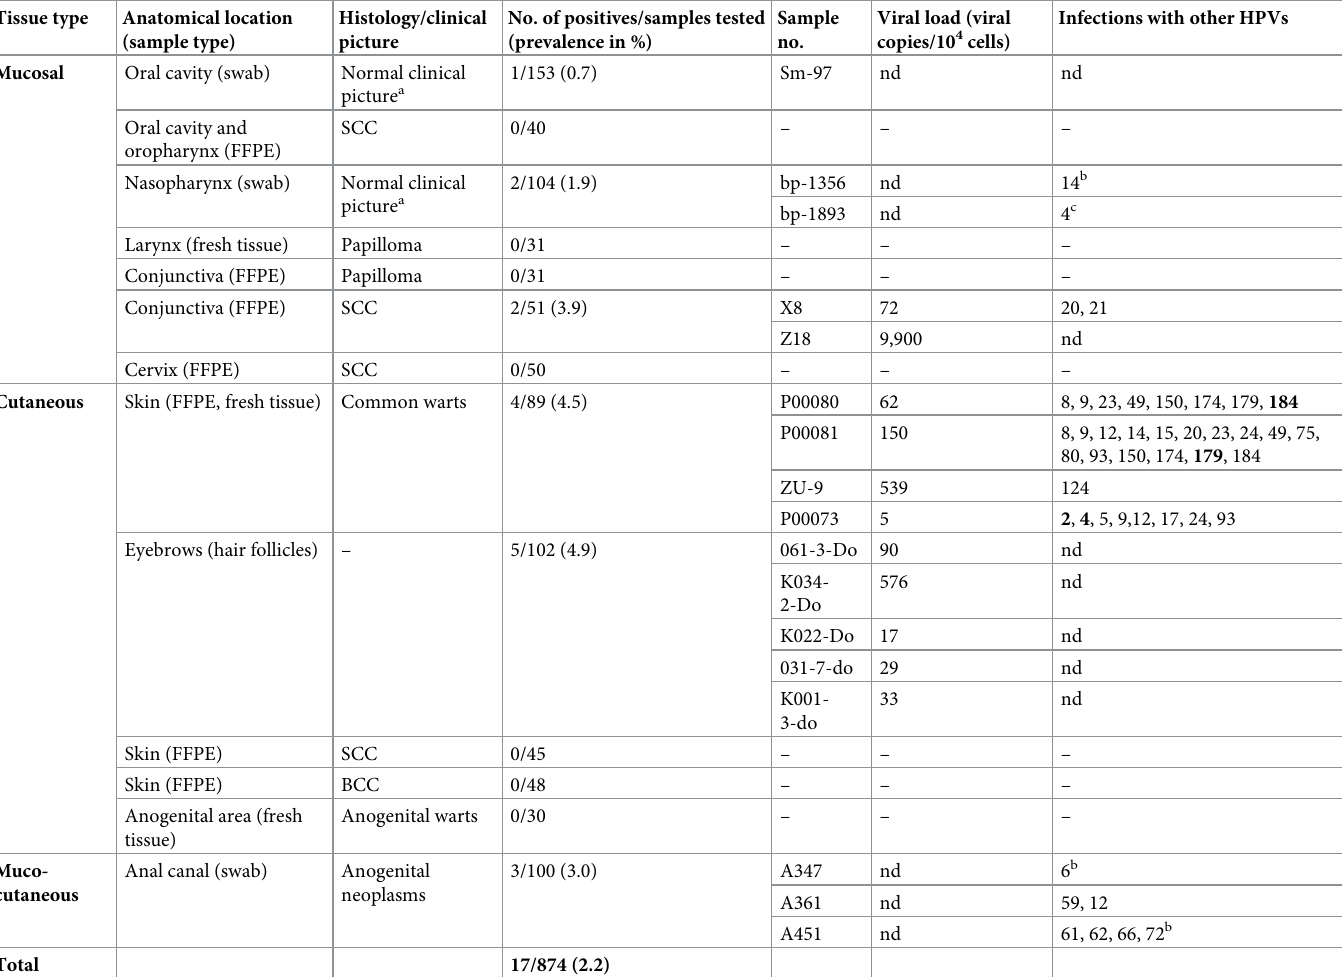
Table 2. Prevalence and tissue tropism of human papillomavirus type 135 (HPV135) in immunocompetent individuals. Tissue